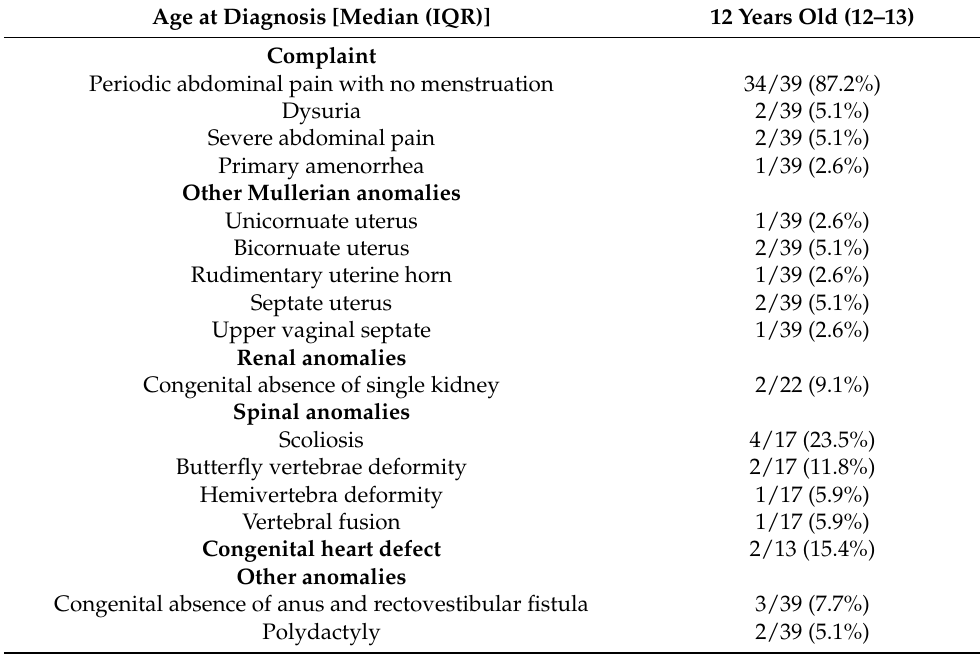
Table 1. Clinical characteristics of 39